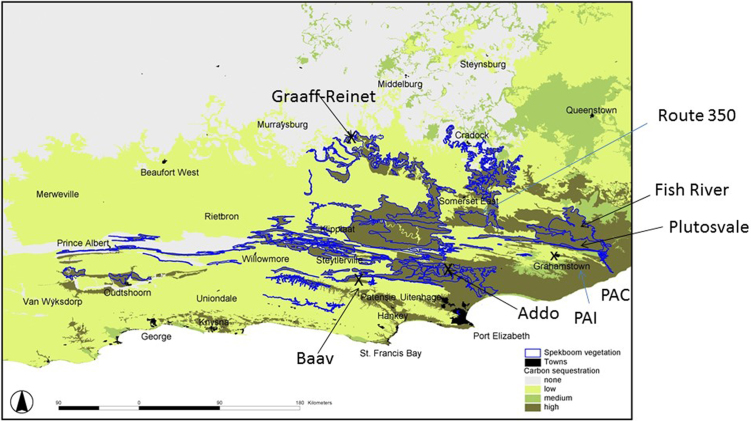
Map of location of collecting sites of various populations of Portulacaria afra. The Blue represents the distribution of the Spekboom Thicket. Baav (Baviaanskloof); Addo Elephant National Park; Grahamstown; Route 350; Fish River; Plutosvale; Port Alfred; Graaff −Reinett. Map Courtesy of Mike Powell.